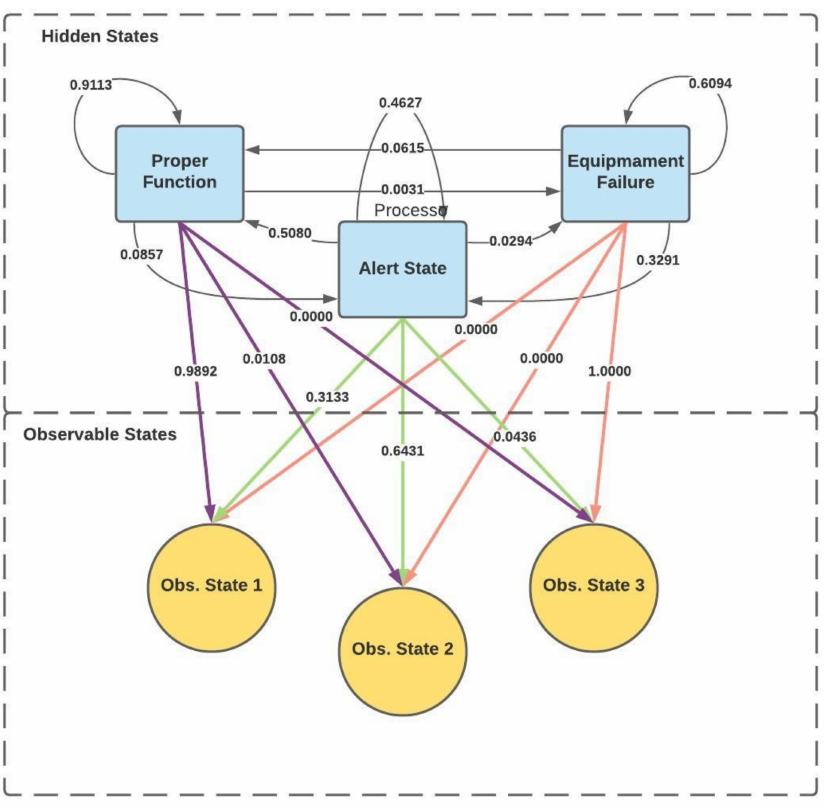
Figure 8. HMM scheme for transition and emission.